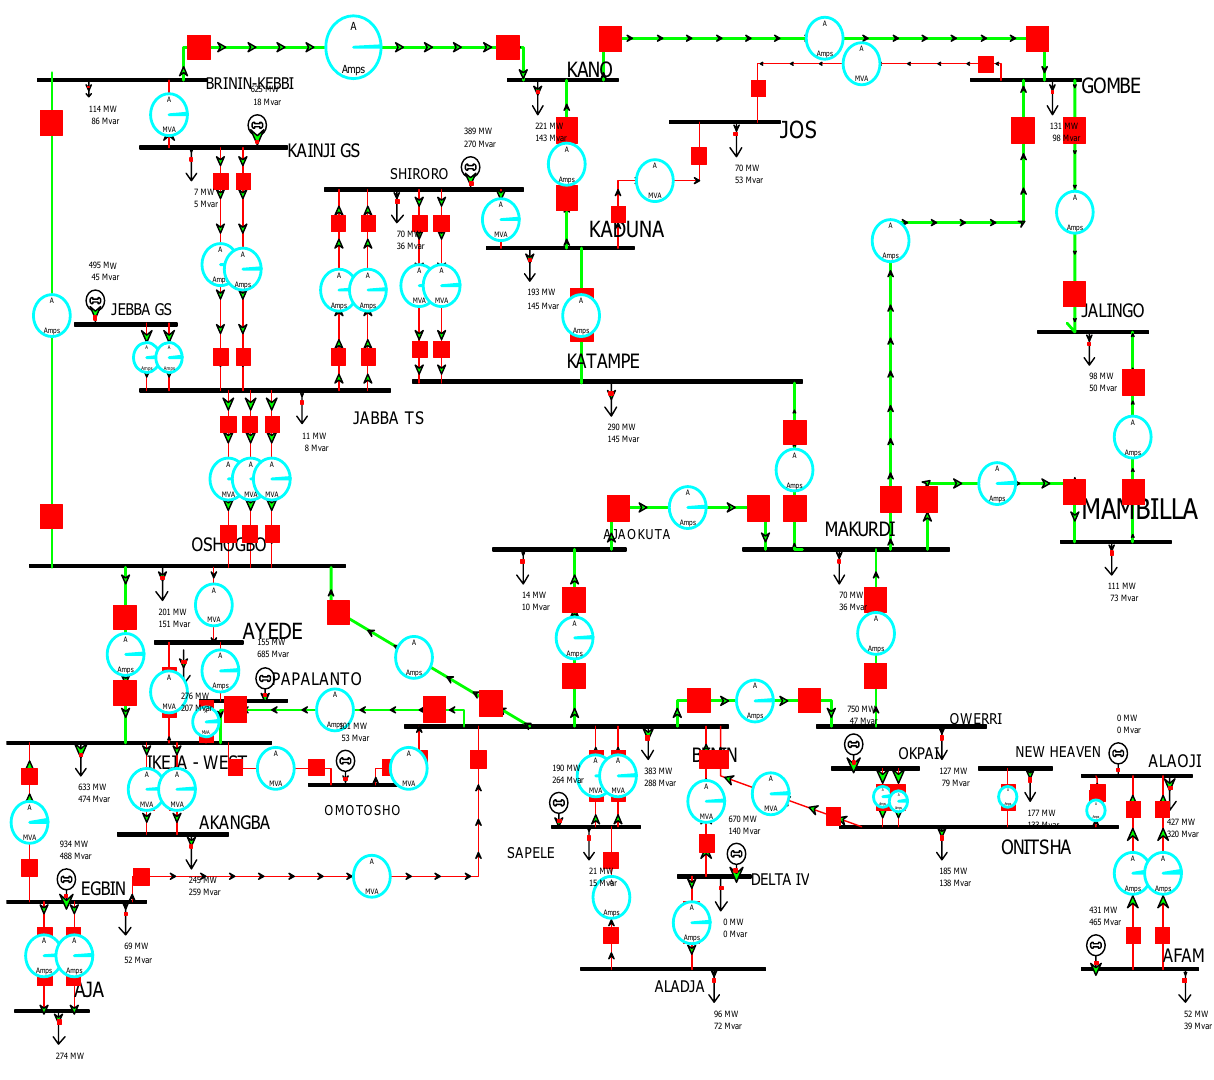
Fig. 4 Integrated 750-kV super grid in power world simulator (run